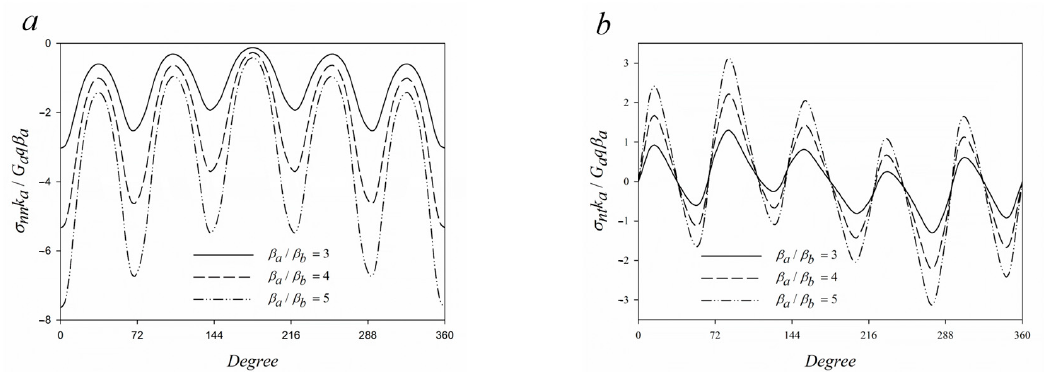
Figure 10. Interfacial ( a ) normal and ( b ) shear stress of a coated pentagonal hole ( w = 0.05 , G b / G a = 3 , k b / k a = 2 , ν b = 0.3 , ν a = 0.3).